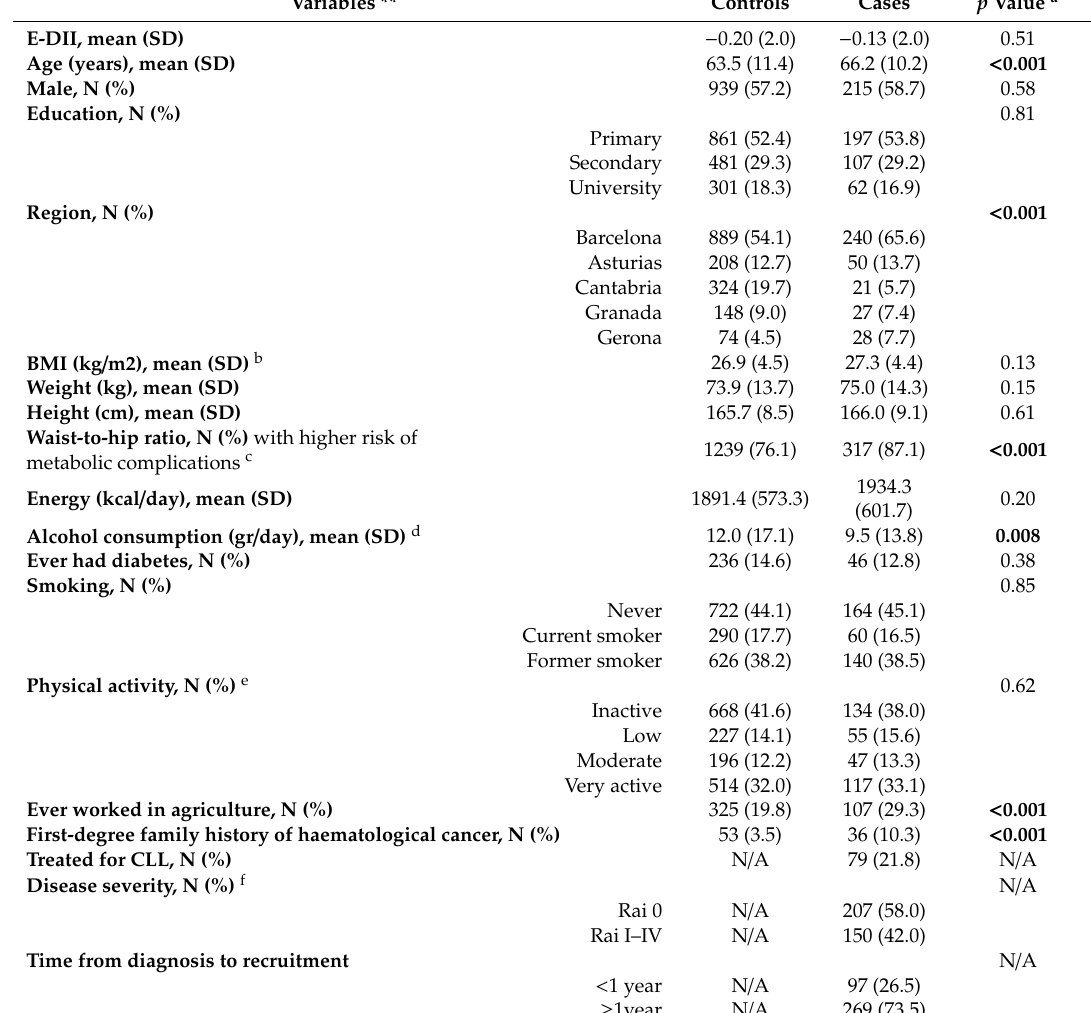
Table 1. Baseline characteristics of chronic lymphocytic leukaemia (CLL) cases and controls in the multicase-control (MCC) Spain